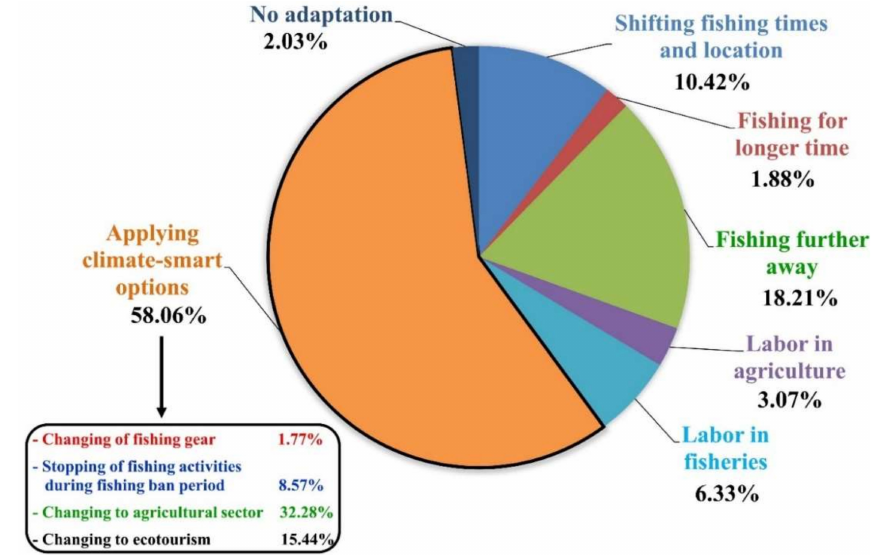
Figure 4. Fishers’ adaptation